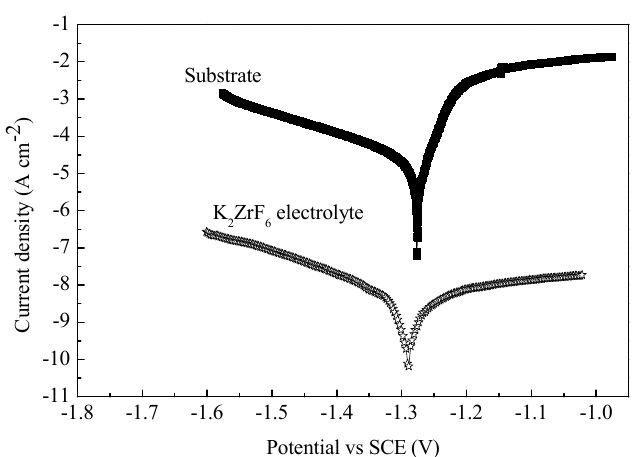
Figure 12. The potential dynamic curves of the ZrO 2 ceramic membranes and the substrate.